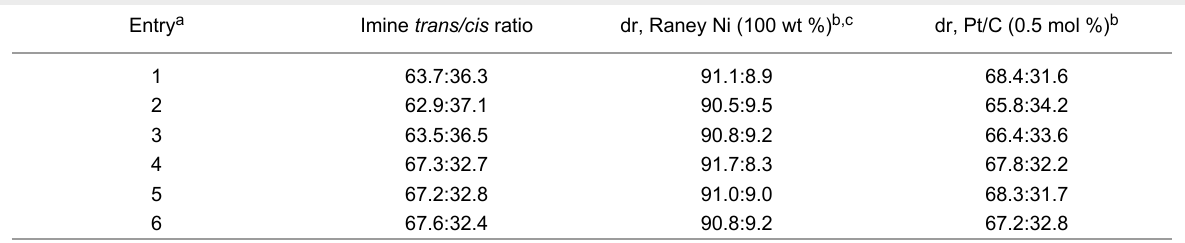
Table 3: Imine 2e (Scheme 1) reduction product profiles using different starting trans/cis ratios.